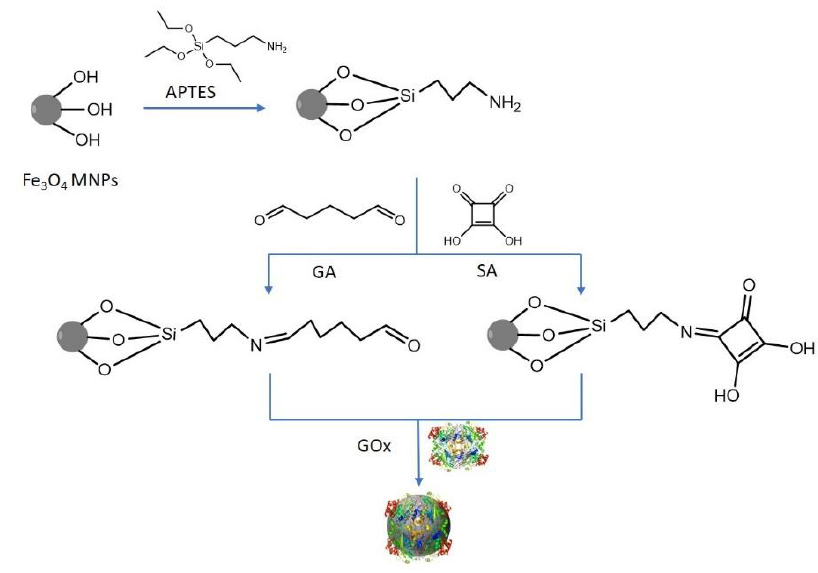
Figure 1. Representative scheme for MNPs functionalization and GOx coupling.